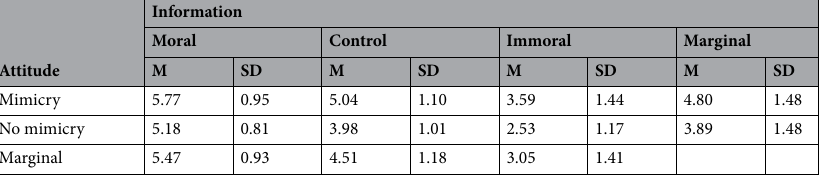
Table 1. Means and standard deviations for the moral character judgments in Study 1. M and SD represents mean and standard deviation,